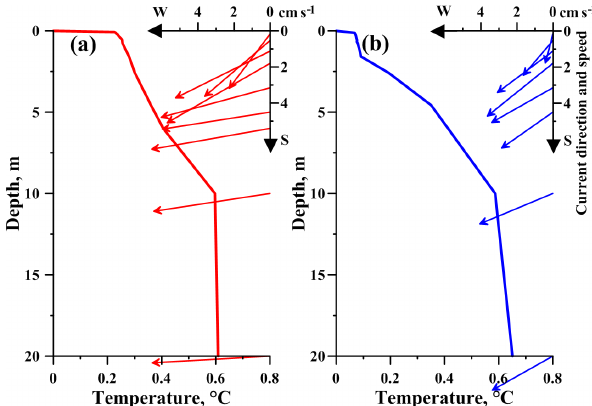
Figure 3. Temperature and current velocity vector profiles mea- sured from 14:00 to 16:00LT (local time) on 6 March 2017 at (a) station S1 and (b) station